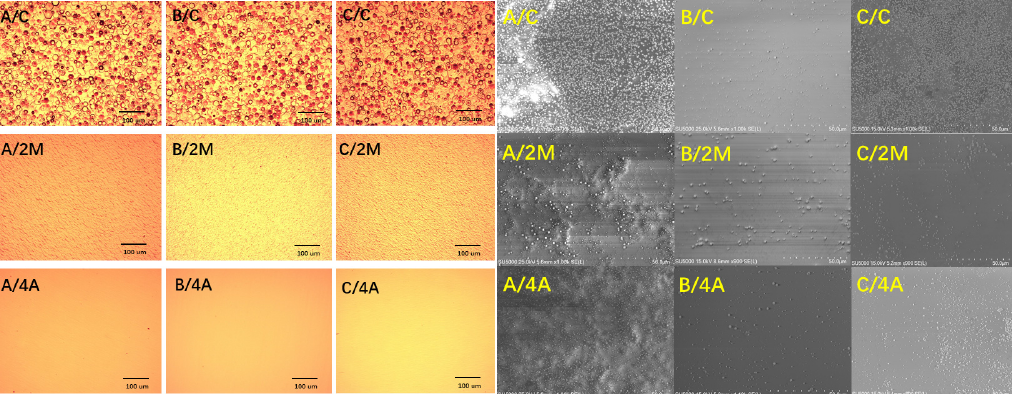
Figure 1. Optical microscope images of all samples before KOH etching and SEM images of all samples after KOH etching in which the form of the sample/substrate is marked.